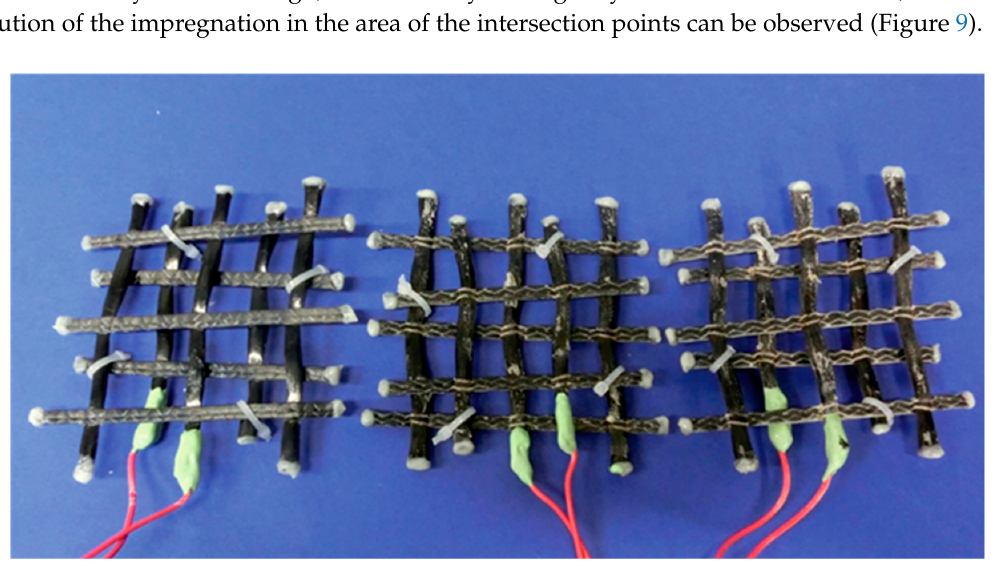
Figure 8. SEM images of E4: unpolarized reference ( a ), after polarization at level 1 ( b ), level 2 ( c ) and level 3 ( d ).